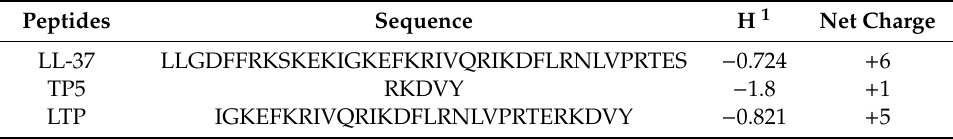
Table 1. Key physicochemical parameters of the parental and hybrid peptides. Peptides